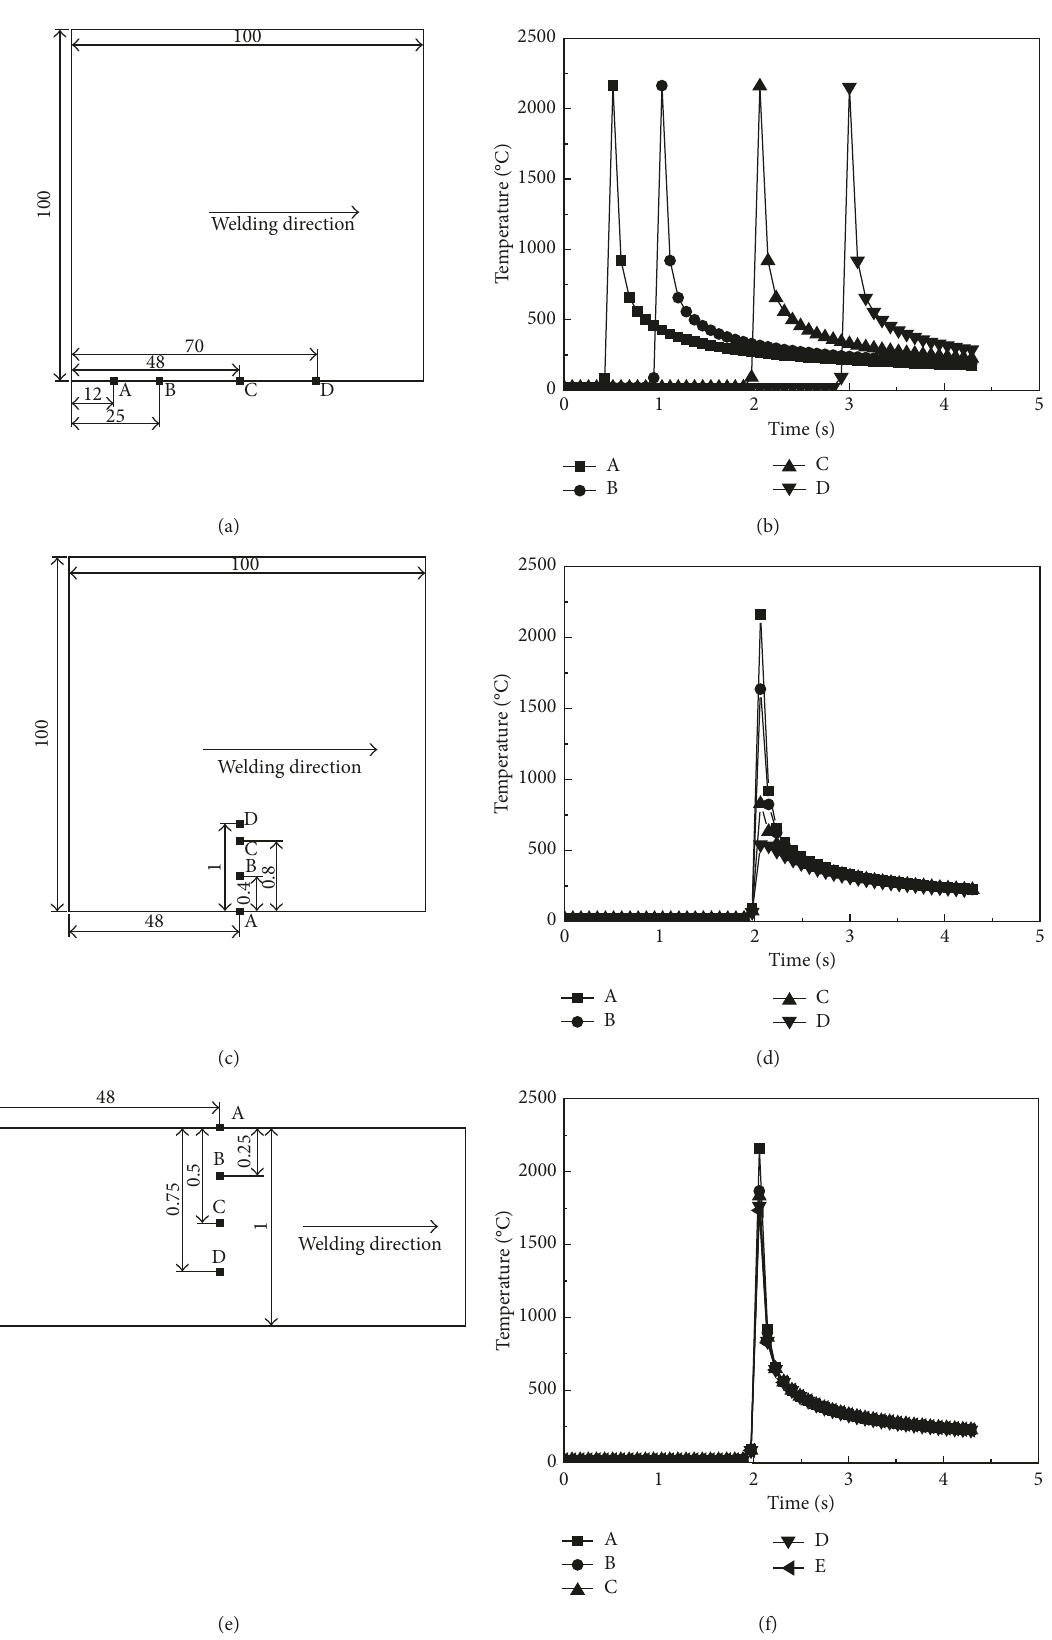
Figure 15: Schematic diagram of the point positions and thermal cycling curve of the laser welding: (a, b) center line, (c, d) vertical to the center line, and (e, f) direction of